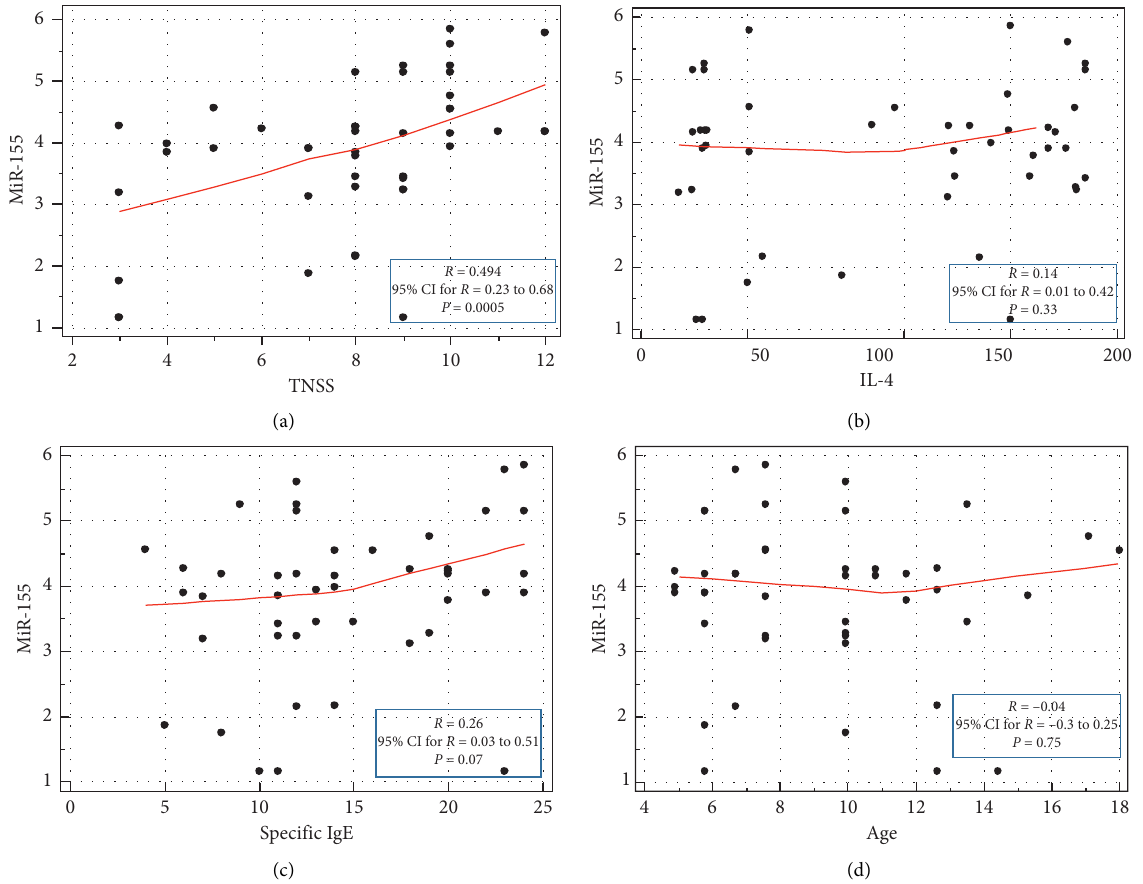
Figure 3: Correlations between miR-155 and (a) TNSS, (b) IL-4, (c) specific IgE, and (d) age among AR